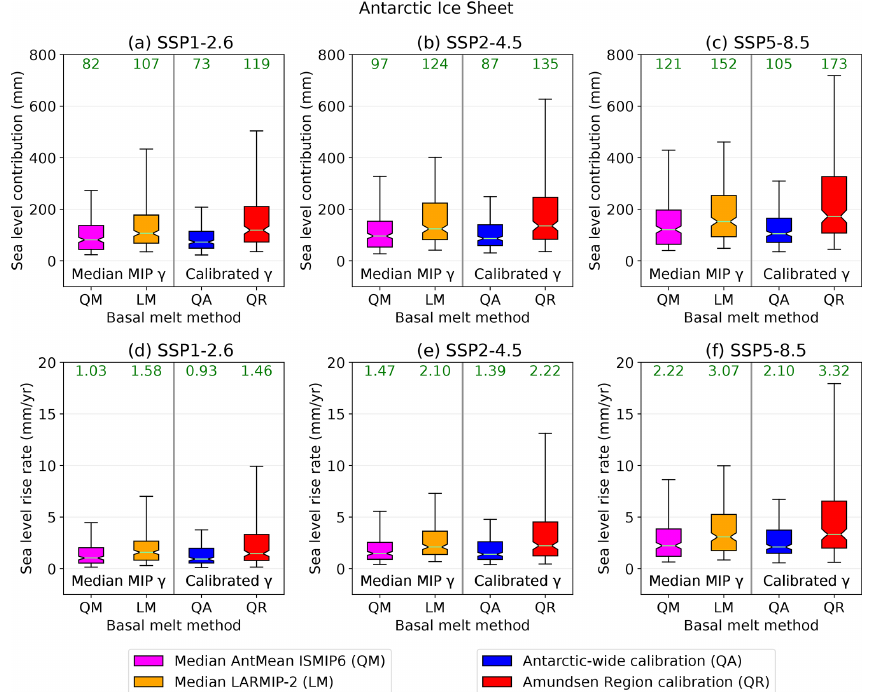
Figure 8. Projected Antarctic sea level response for SSP1-2.6, SSP2-4.5 and SSP5-8.5. (a) – (c) Show the sea level contribution in 2100 compared to the period 1995–2014 and (d) – (f) the sea level rise rates over the period 2081–2100. The spread is determined by the (calibrated) ESM-RF pairs. The green numbers indicate the median values (corresponding to the horizontal lines in the boxes), the boxes show the 25– 75 percentiles and the whiskers the 5–95 percentiles. The left section of each graph shows projections using a single median basal melt sensitivity from the ISMIP6 AntMean method (QM) and from LARMIP-2 (LM). The basal melt computation methods on the right are our main projections with calibrated basal melt sensitivities on ice discharge observations of the Amundsen Region (QR) and the total AIS (QA). The ESM-RF pairs that could not be calibrated are removed from all basal melt methods so that the same models are included in the comparison. If ESMs did not simulate year 2100, 2099 was used